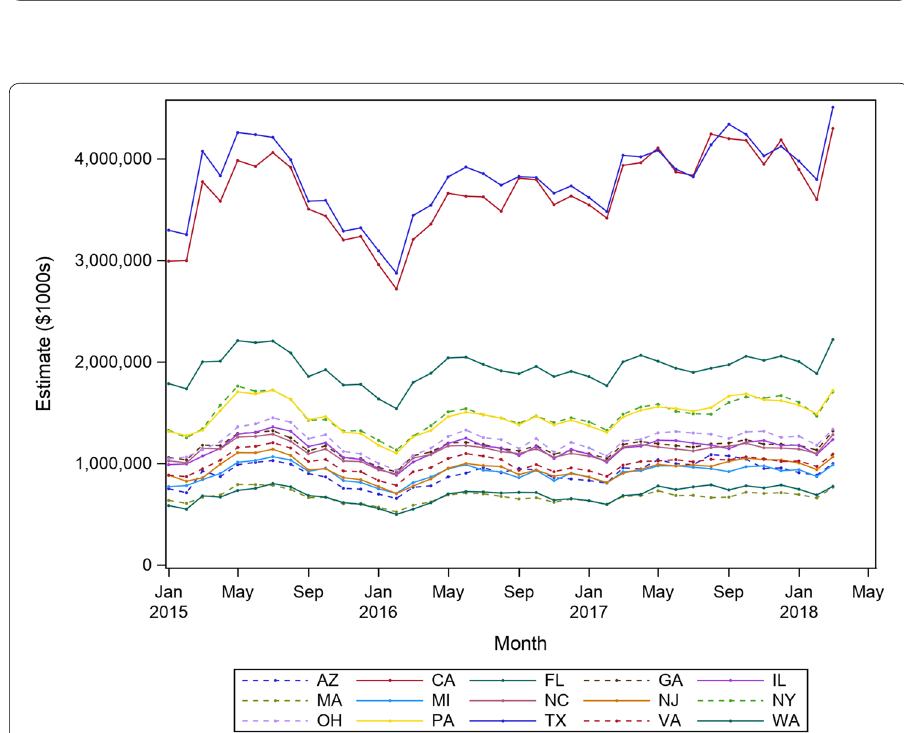
Fig. 9 State-level estimates of retail sales over time for NAICS 447 (gasoline